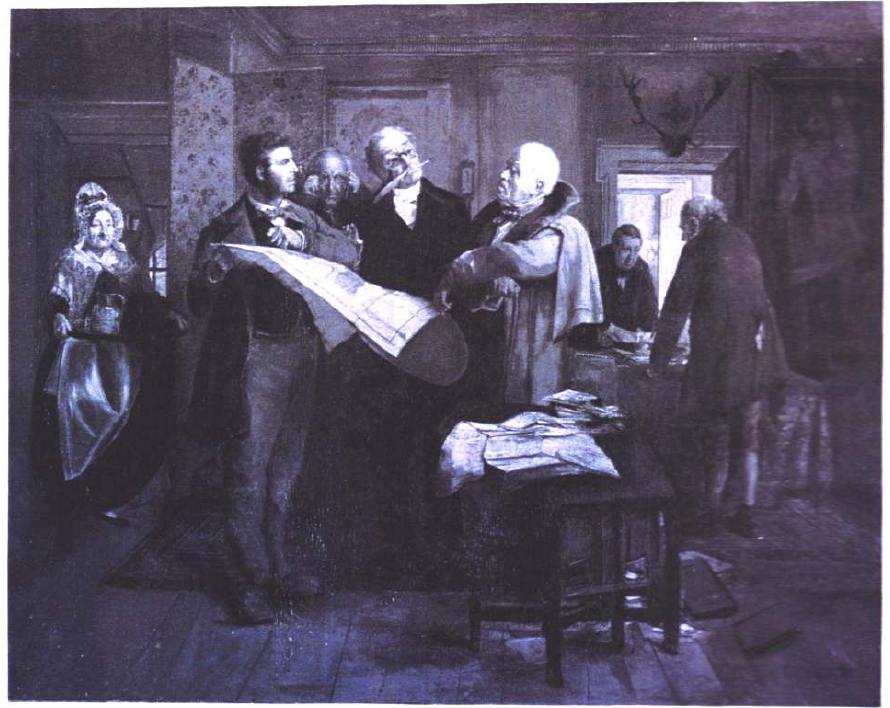
Reproduced with the kind permission of the Frick Library, New